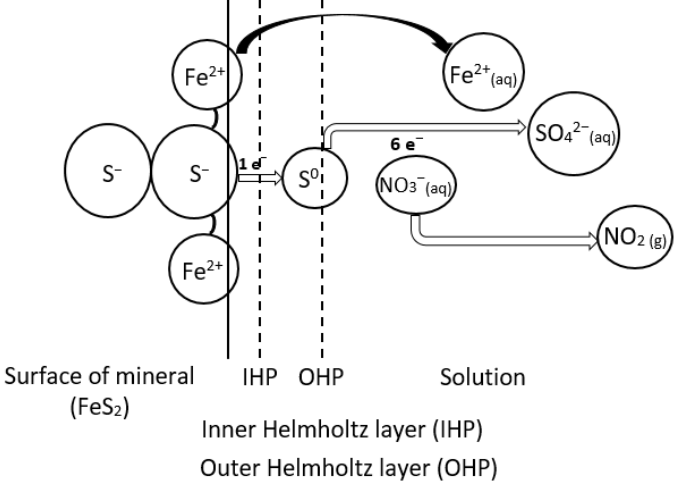
Figure 3. The proposed pyrite dissolution mechanism in nitric acid solution. Figure 4 represents the energy band diagram of the pyrite – solution interface. Based on